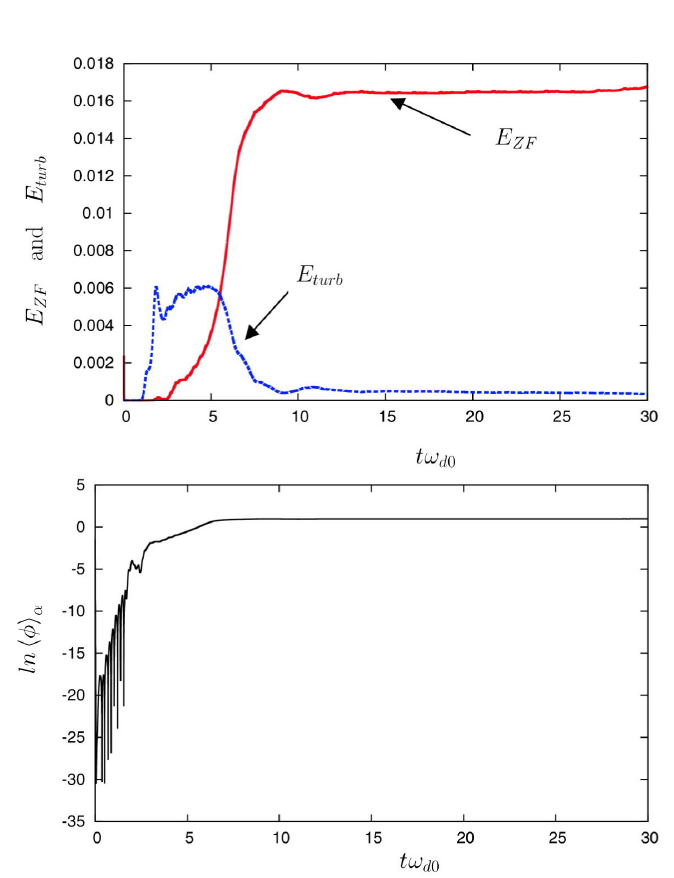
Figure 2. Plot of E turb , in the dotted and blue line, in the (fluid) regime dominated by the Reynolds tensor. In the bottom panel, the time evolution of the squared mean potential (cid:104) φ (cid:105) in a logarithmic α scale. We observe that when the zonal flow saturates at high level, the turbulence is strongly reduced. Here, the polarization parameter C i is 0.25. In the bottom panel in Figure 2, the corresponding evolution of the zonal flow component (cid:104) φ (cid:105) , taken at ψ = 1 (in (cid:52) ψ α 2